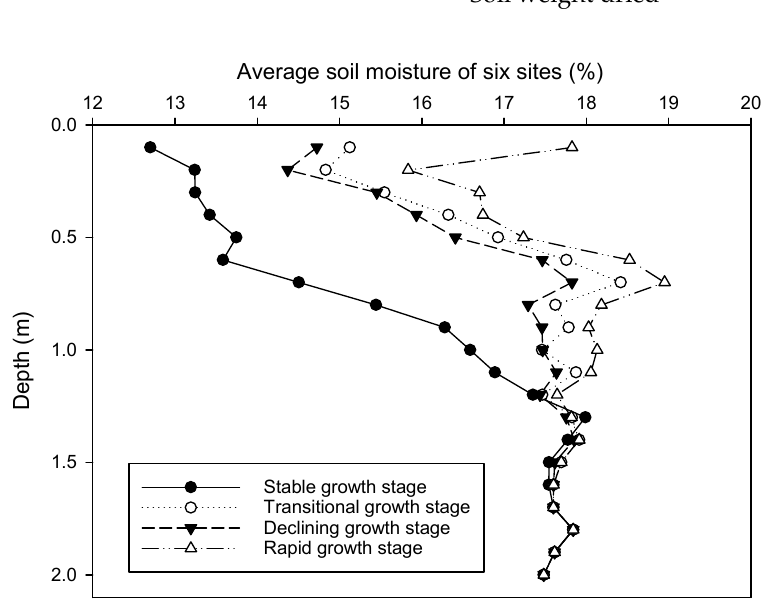
Figure 3. Variation characteristics of soil moisture and depth with different